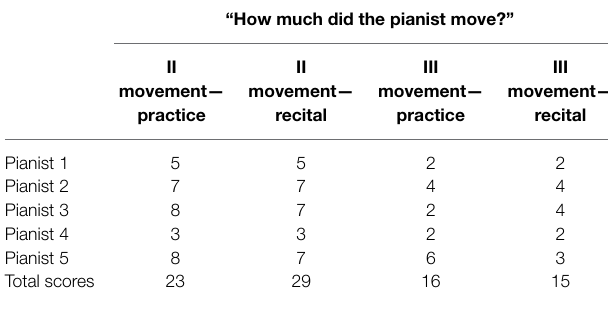
TABLE 1 | Perceived intensity of pianist’s body